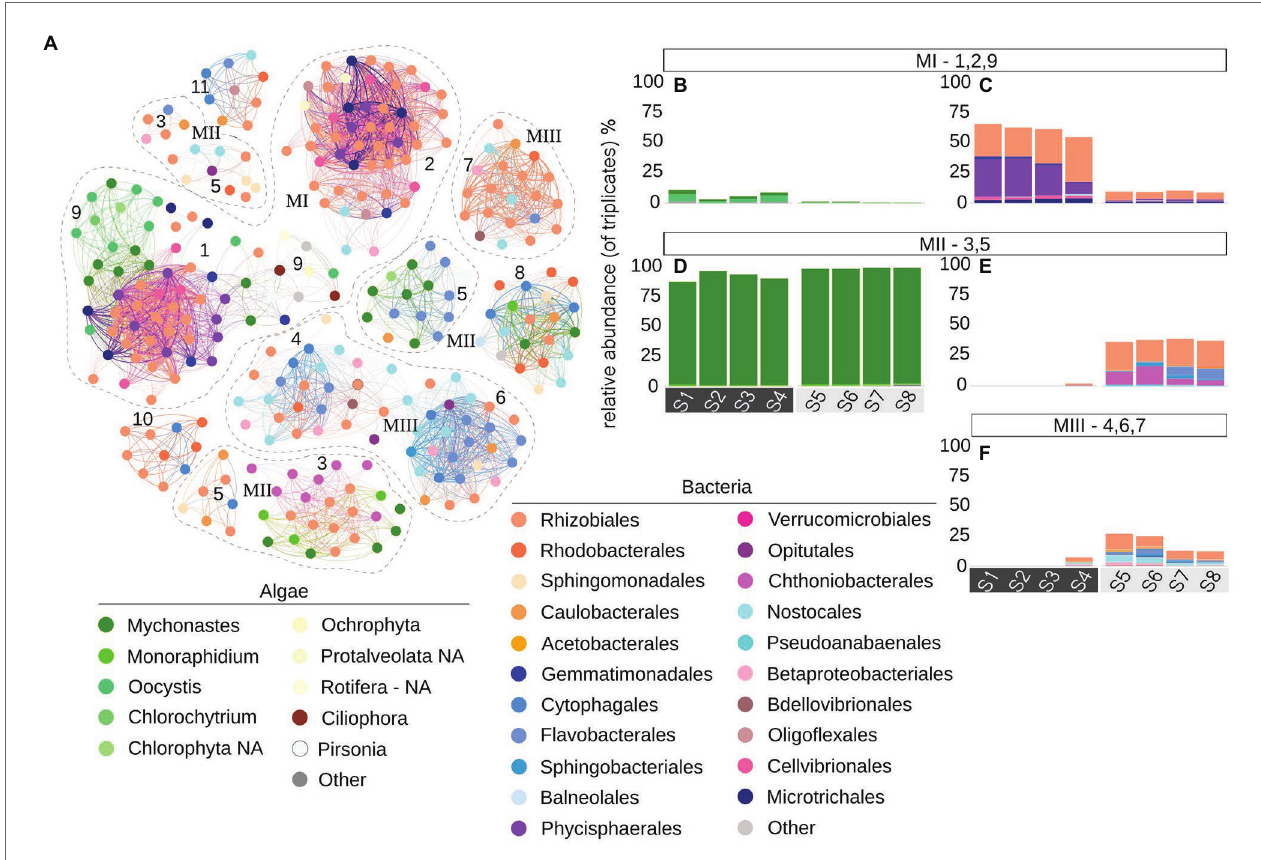
FIGURE 7 | (A) Co-occurrence network (Pearson) of eukaryote (genus level) and prokaryote (order level) ASVs (network nodes). Only edges with weight > 0.3 were included in the plot for ease in visualization, and nodes with zero edges were excluded. Modules represent node clusters grouped based on their shared positive correlations (edges). We clustered modules into three major clusters (based on their correlation values with temperature, see Figure 8 ). MI (modules 1, 2, 9), MII (modules 3, 5 – spread out due to the exclusion of edges with weight < 0.3), and MIII (modules 4, 6, 7). Relative abundances of ASVs of grouped modules are displayed in (B) (MI – 18S), (C) (MI – 16S), (D) (MII – 18S), (E) (MII – 16S), and (F) (MIII – 16S). Bar plot facets indicate temperature regime in PBR, warm: S1–S4, cold: